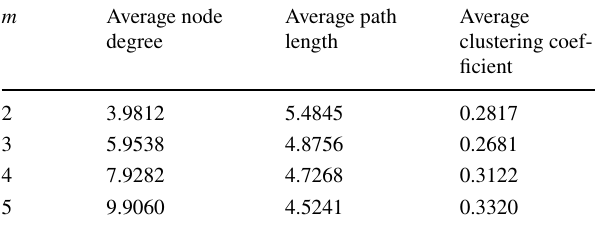
Table 3 Characteristic parameters of the final evolution network with different values of m m Average node Average path degree